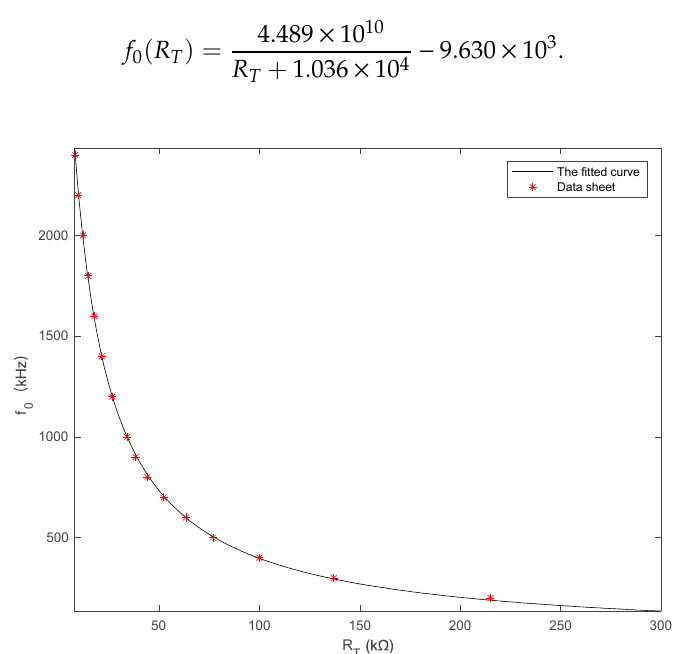
Figure 7. The curve of repetition frequency f 0 under different values of resonance resistance R T .